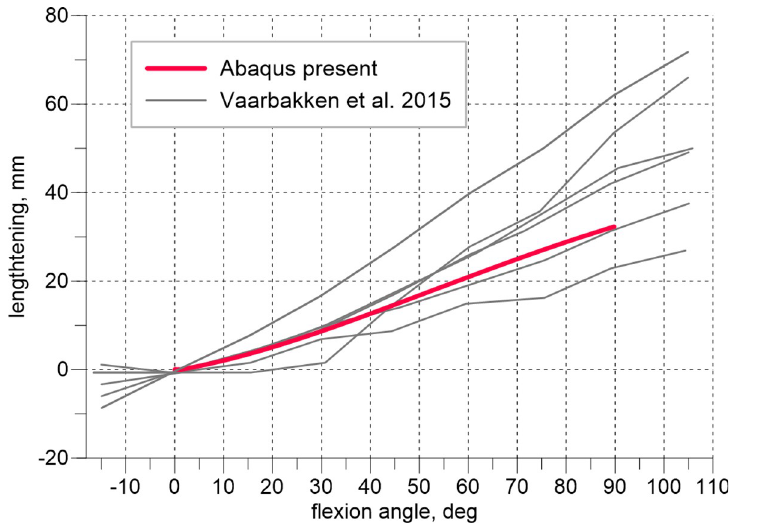
Fig 5. Lengthening of the quadratus femoris vs. hip flexion angle.